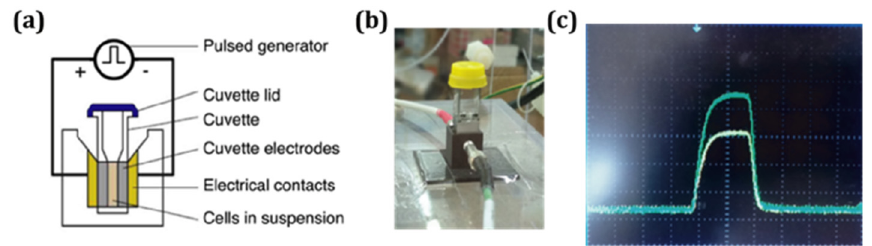
Figure 1. ( a ) Schematic design of PEF application to platelets. ( b ) Details of the cuvette treatment chamber, with electrical connections. ( c ) Voltage and current pulse example of the experiments, (green) voltage 1 kV/div, (yellow) current 50 A/div, 1 µs/div.